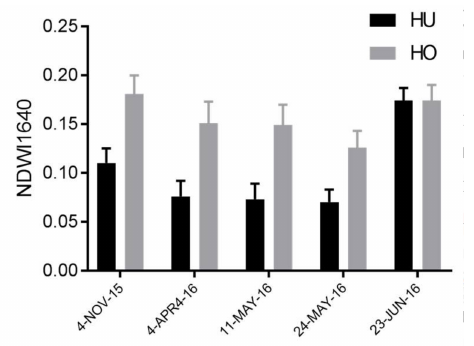
Figure 7. Hollows’ and hummocks’ near-surface moisture temporal trends for five time periods based on NDWI 1640 (SASI HSI) at the Mer Bleue bog (mean and standard